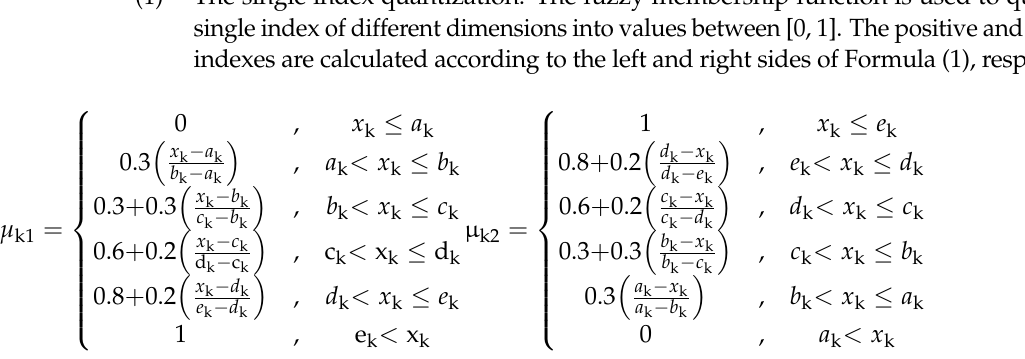
(1) The single index quantization. The fuzzy membership function is used to quantify a single index of different dimensions into values between [0, 1]. The positive and negative indexes are calculated according to the left and right sides of Formula (1), respectively.